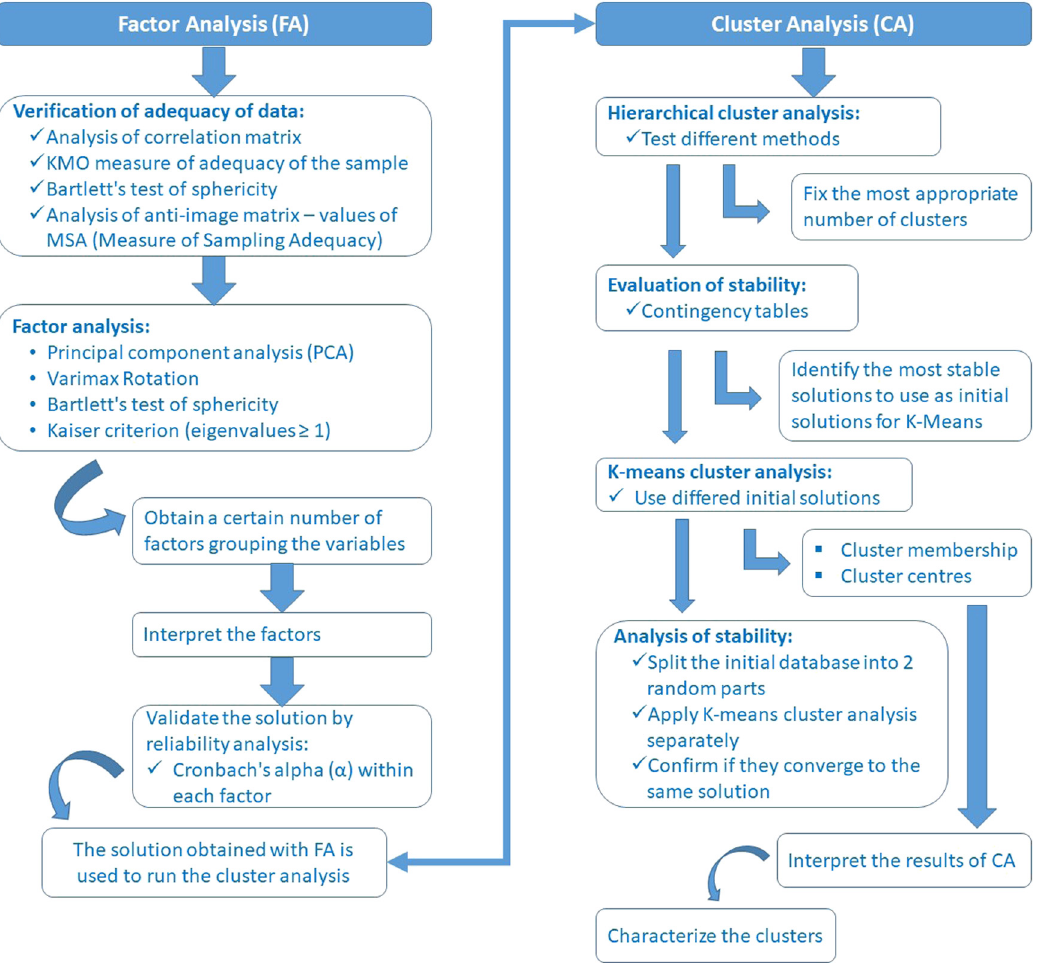
Figure 1: Schematic representation of the statistical procedures